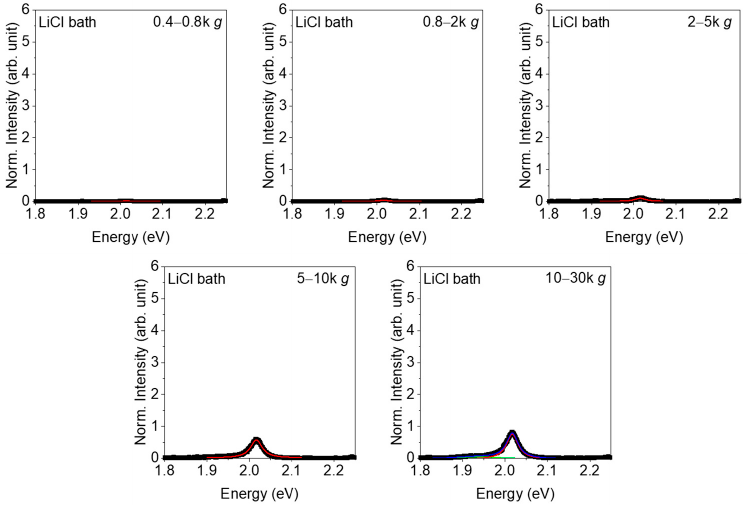
Figure A9. Photoluminescence spectra ( λ exc = 532 nm) the WS 2 nanosheet dispersions, exfoliated by tip sonication with a 30% amplitude. The bulk starting material was bath sonicated in H 2 O prior to exfoliation. The PL was fitted by Lorentzians for quantitative analysis. Spectra of fractions which were collected during liquid cascade centrifugation but did not show any PL are excluded.